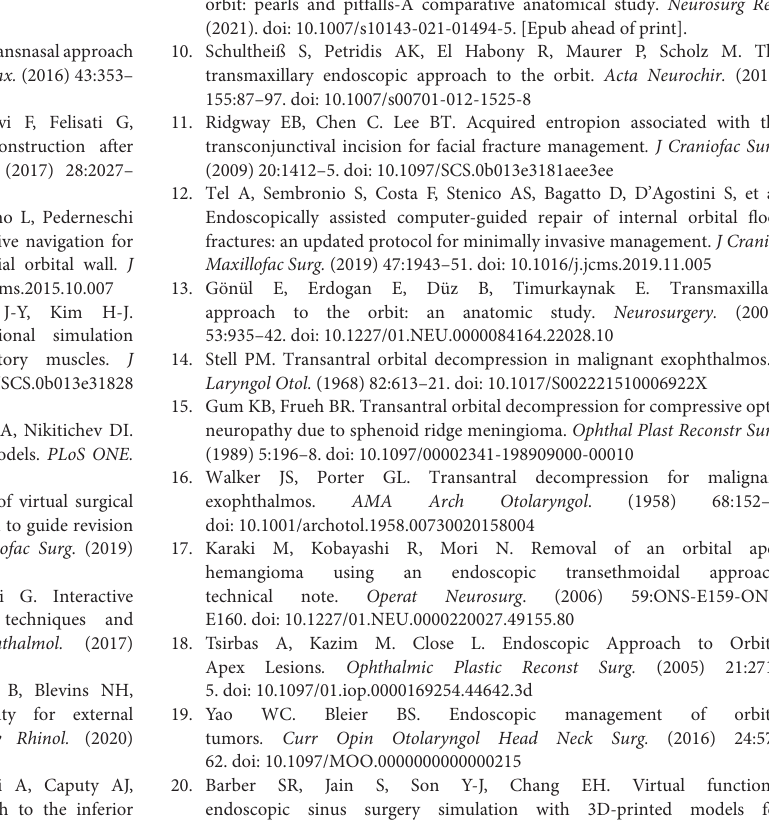
Supplementary Video 3 | Key steps of the endoscopic surgical